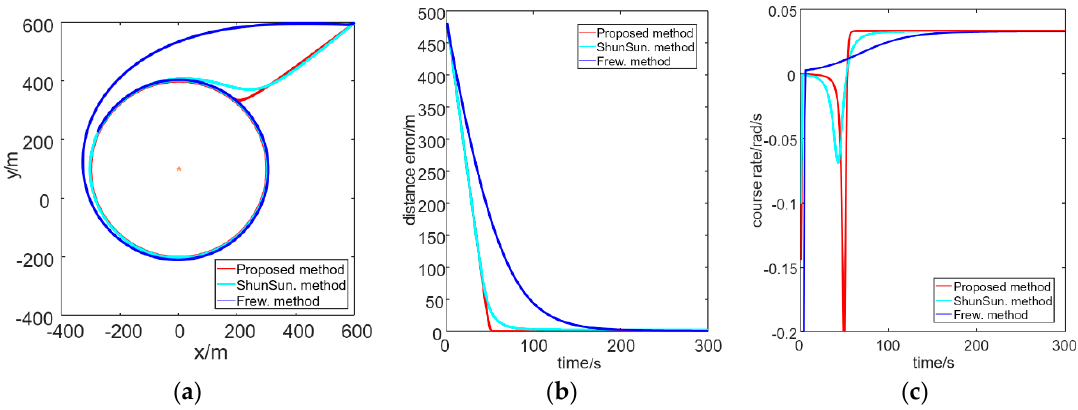
Figure 10. Experiments results with respect to an initial UAV position far away from the standoff circle. ( a ) Trajectories of UAVs; ( b ) Distance error versus time; ( c ) Course rate versus time.